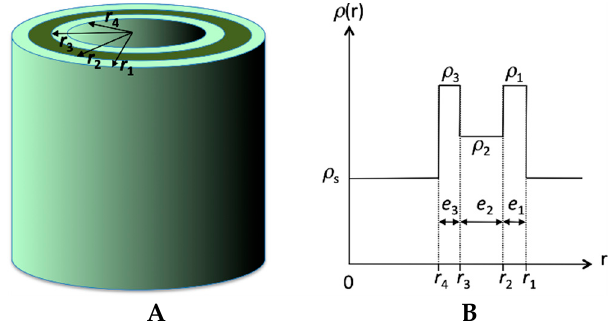
Figure 8. Model of tube with three layers. ( A ) definition of the different radiuses; ( B ) radial scattering length density profile ρ ( r ).